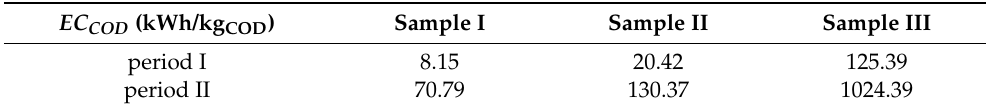
Table 2. Energy consumption of swine wastewater via EO treatment by Ti 4 O 7 anode at 50 mA/cm 2 current density.